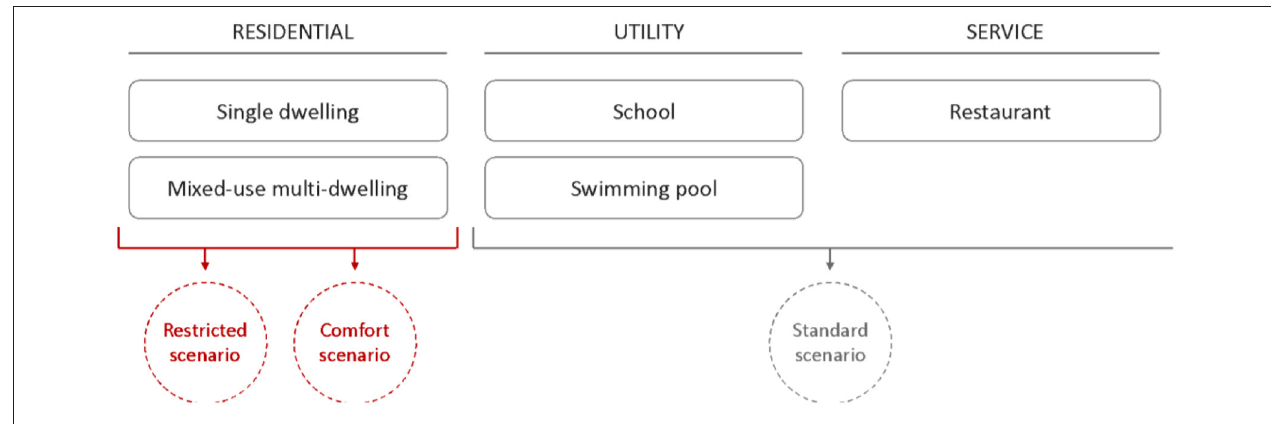
FIGURE 4 | Thermal comfort scenarios.